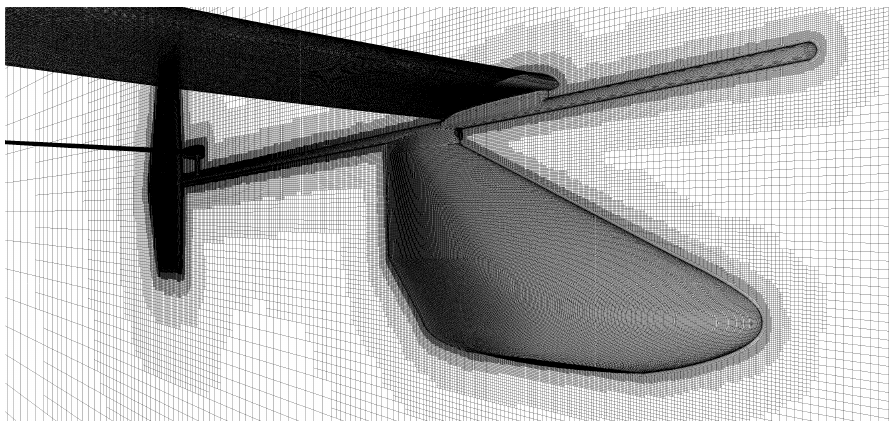
Figure 8. Trimmed hexahedral mesh around the